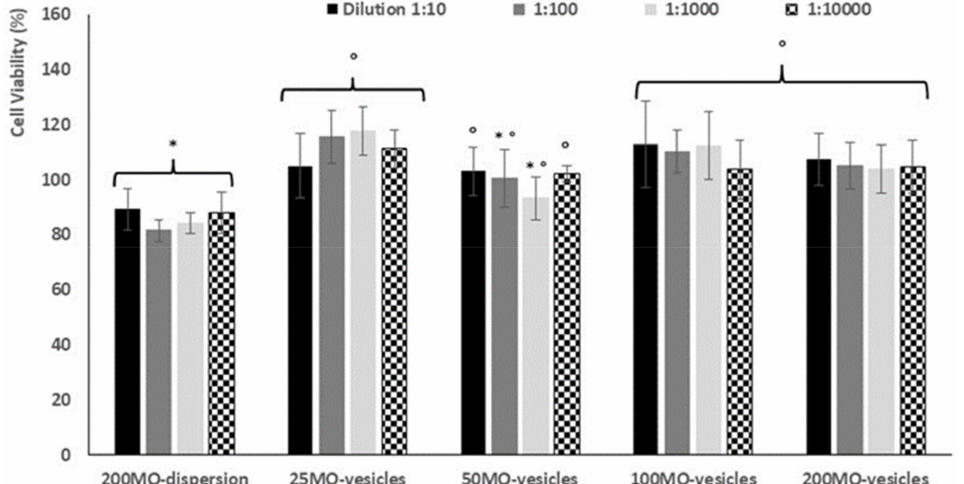
Figure 4. Viability of cells treated with quercetin and mint oil (200 mg/mL) in dispersion or with vesicles loading quercetin and mint oil (25, 50, 200, 200 mg/mL) properly diluted. Mean values (bars) ± standard deviations were reported ( n = 8). The same symbol (*, ◦ ) indicates the same value. Using the dispersion, the viability of the keratinocytes was ~85%, regardless of the